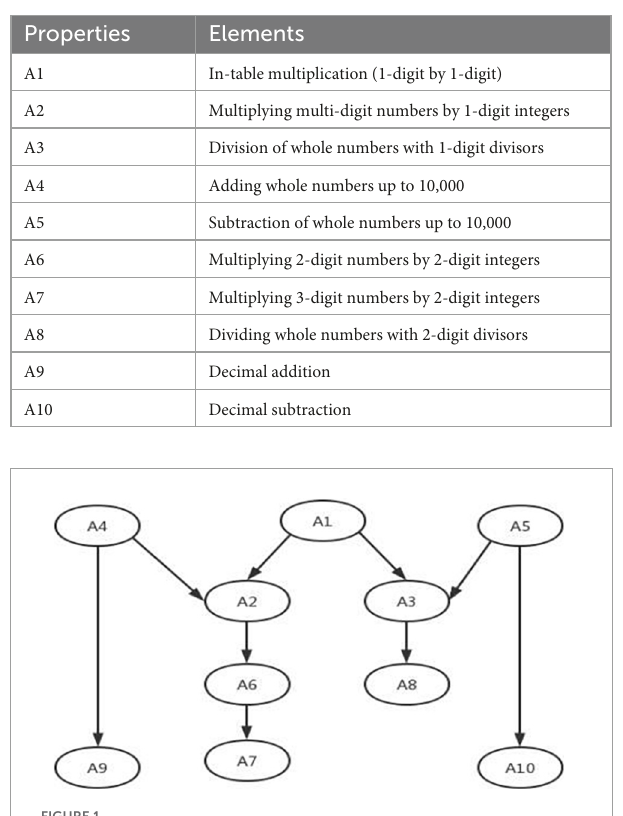
TABLE 3 R matrix under attribute hierarchy